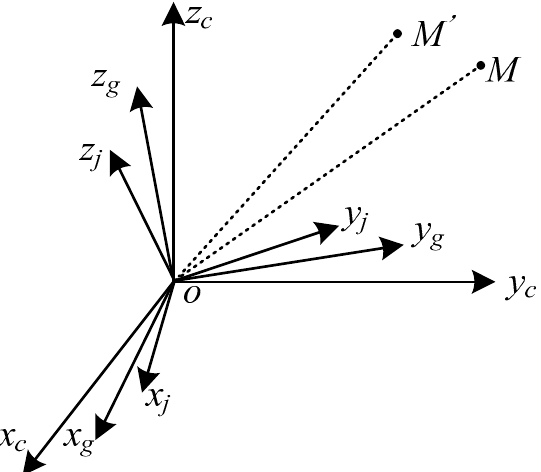
Figure 3. Attitude relationship of each coordinate system of the electro-optical device. Figure 3. A tt itude relationship of each coordinate system of the electro-optical device. The coordinate matrix A (cid:48) of the coordinate matrix A (cid:48) relative to the horizontal g j